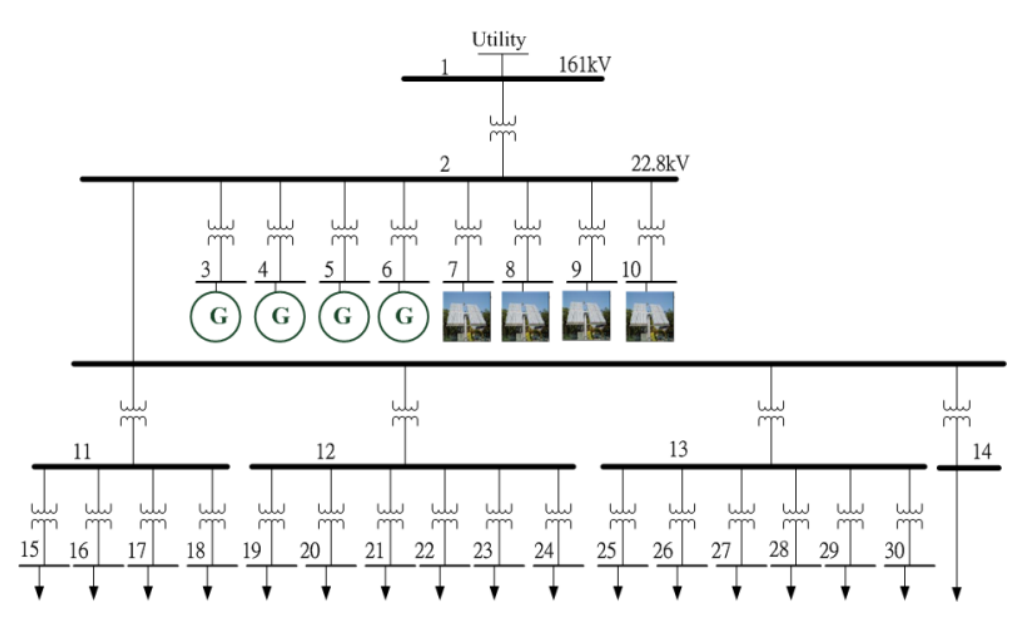
Figure 10. One-line diagram of studied power system. Appl. Sci. 2017 , 7 , 438 Table 1. Cost coefficients and MW limits of generators.